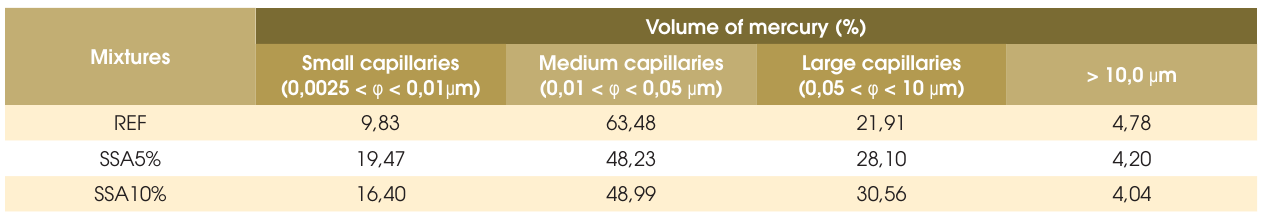
Table 4 – Pore size distribution of REF, SSA5% and SSA10%